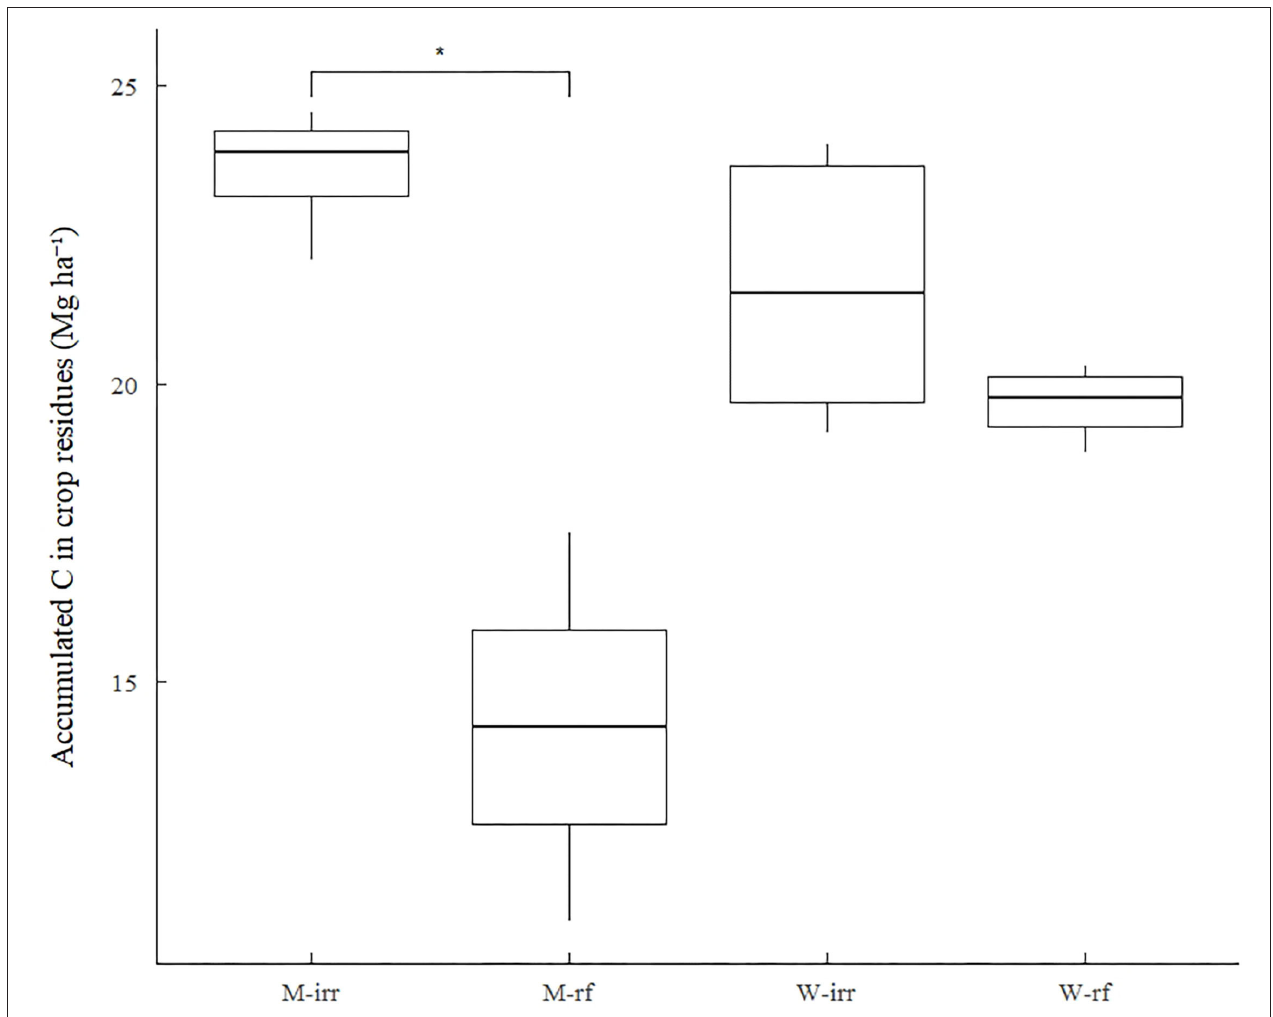
FIGURE 3 | Accumulated C in crops residues (Mg ha − 1 ) in the 7 years of study per crop-irrigation combination. M-irr: maize, irrigated; M-rf: maize, rainfed; W-irr: wheat, irrigated; W-rf: wheat, rainfed. The box plots represent the median ( n = 6), 25th and 75th percentiles. *Represents significant differences (no overlapping of the